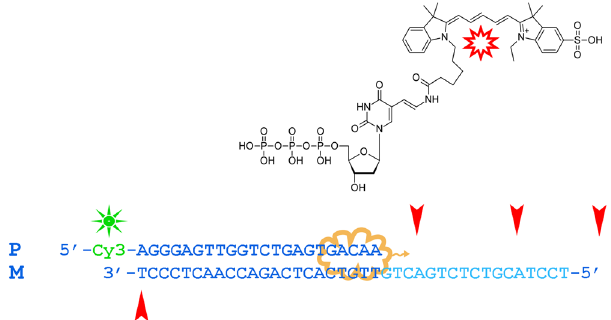
Figure 1. Oligonucleotide model for the PE reaction. The Cy-3 ′ -labeled primer (P) was extended with selected polymerases in the presence of a nucleotide mixture (dATP, dGTP, dCTP, and Y). Red arrows point to sites of nucleotide Y incorporation in the primer or template (M) strands. Cy3 (green) and Cy5 (red) fluorescent labels make detection of the reaction products in the polyacrylamide gel possible via two separate